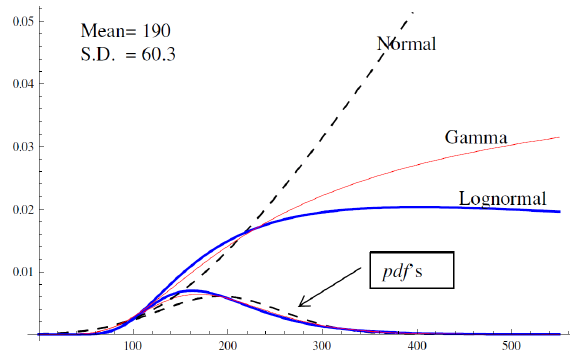
Figure 1. Hazard Functions of Normal, Lognormal, and Gamma Distributions with the Same Means and Standard